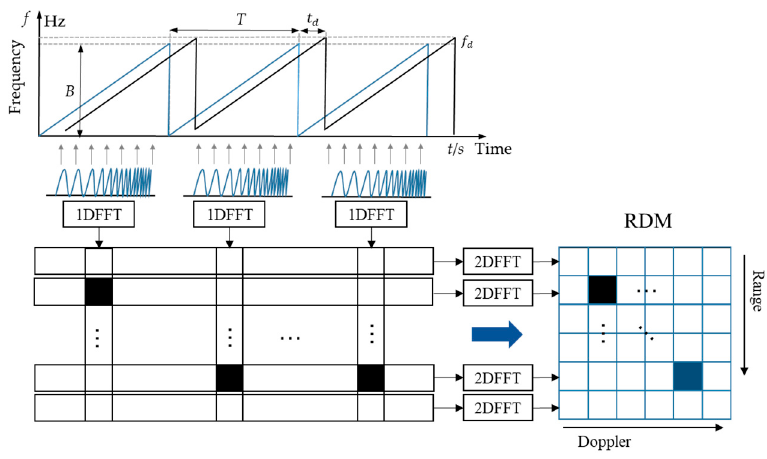
Figure 5. The generation process of RDM.